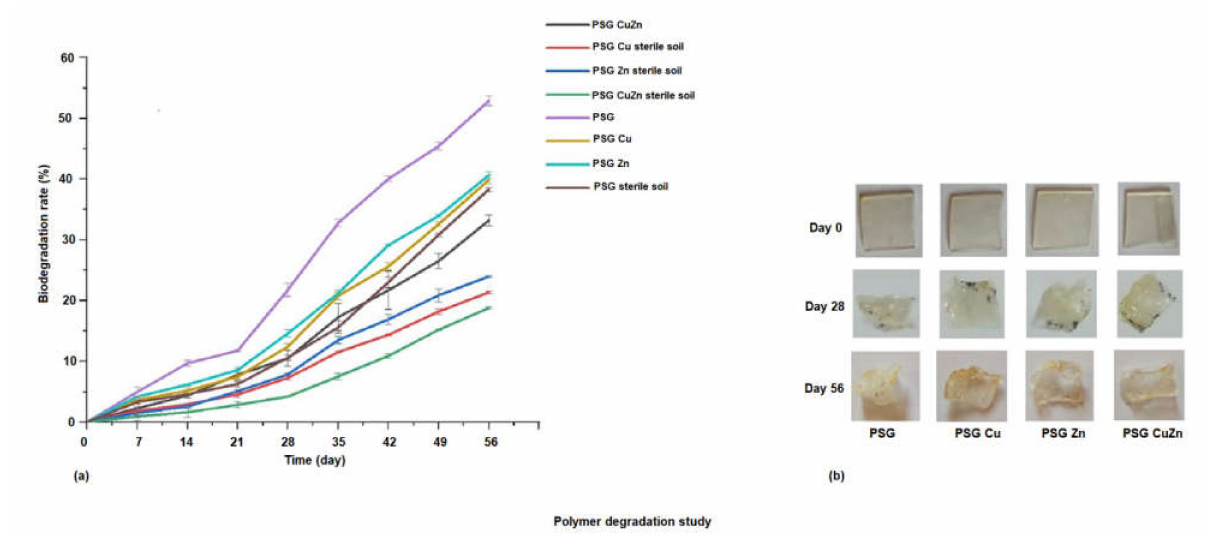
Figure 7. ( a ) Degradation of polymer films incubated in sterile and non-sterile soil over 56 days. ( b ) Polymer films exhibiting visible change on degradation.